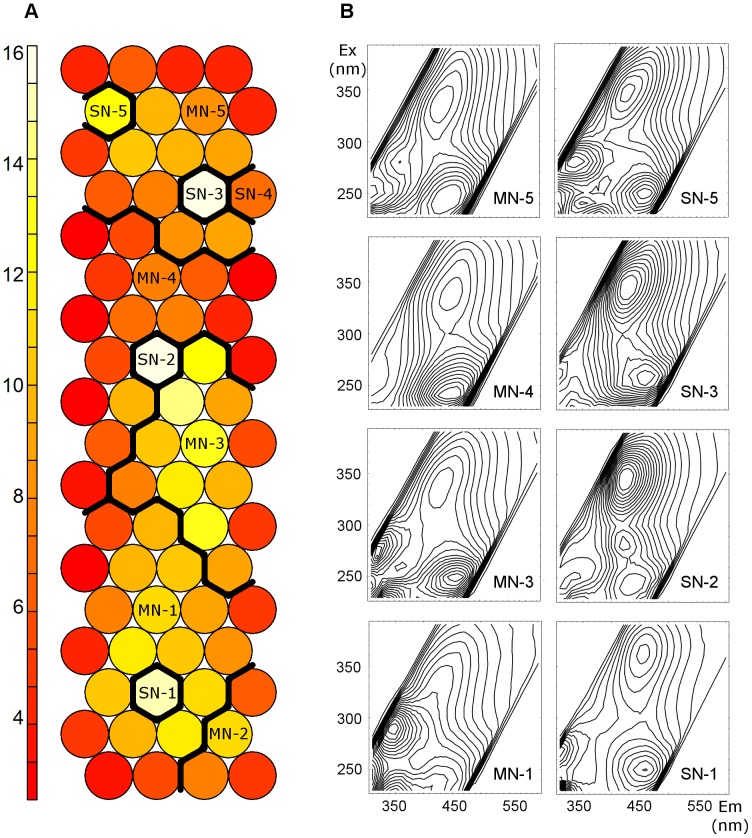
Clustering of the U-matrix of the SOM analysis in the Q-mode.A) Ten regions were defined in the SOM grid (black solid lines), based on hierarchical clustering of the U-matrix. B) EEM prototypes representing the main SOM regions.